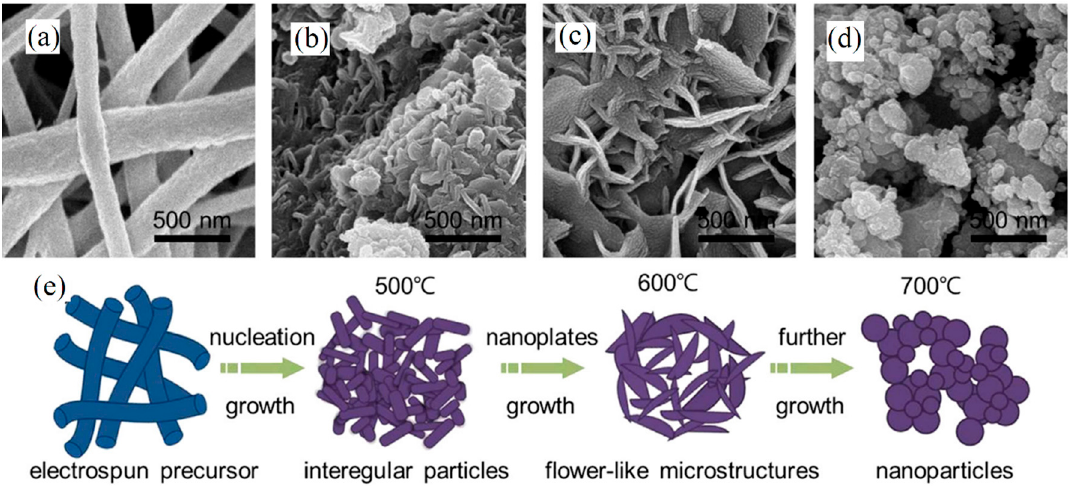
Figure 9. SEM image PVA/ Li 1.2 Ni 0.17 Co 0.17 Mn 0.5 O 2 pristine NFs changes to nanoplates with an open